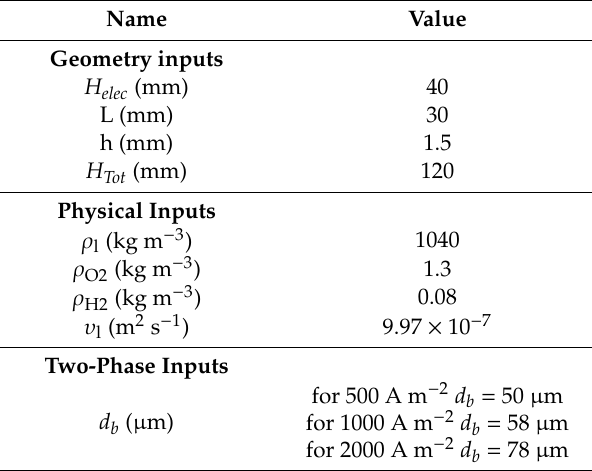
Table 2. The input values for the problem.